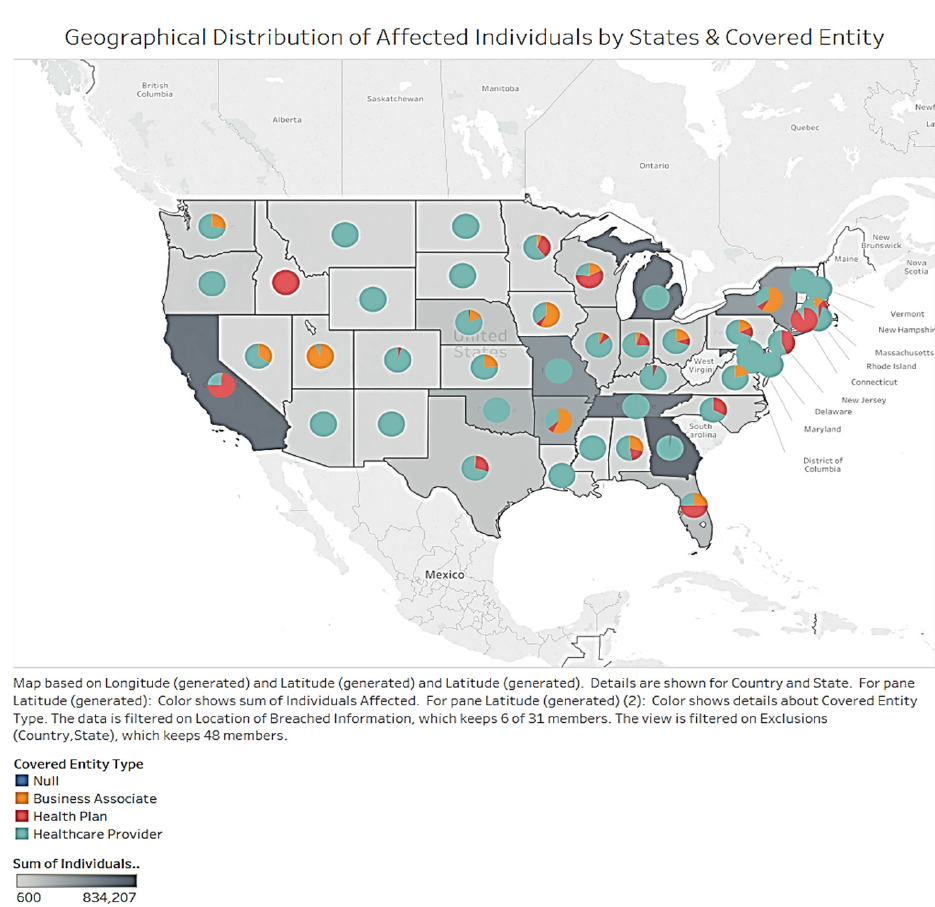
Figure 23. Distribution of affected individuals’ breach location in selected states.